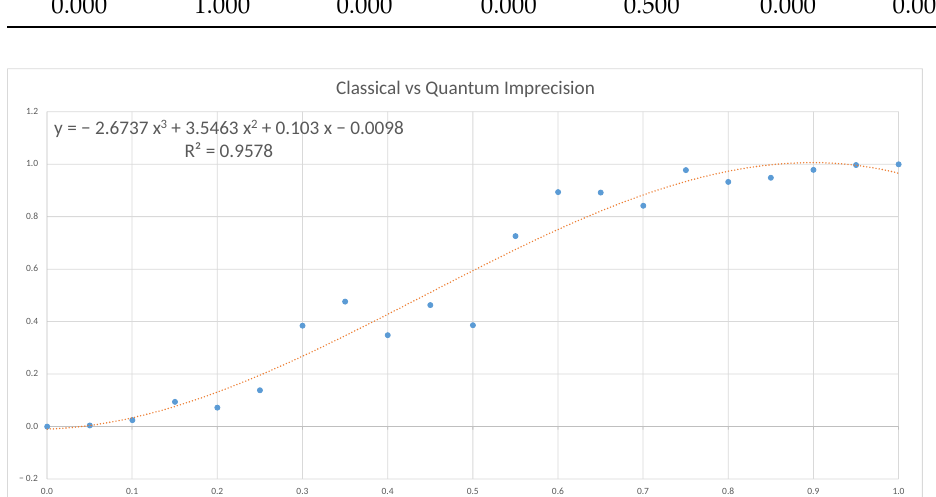
Figure 12. Plot of the results obtained for the imprecision